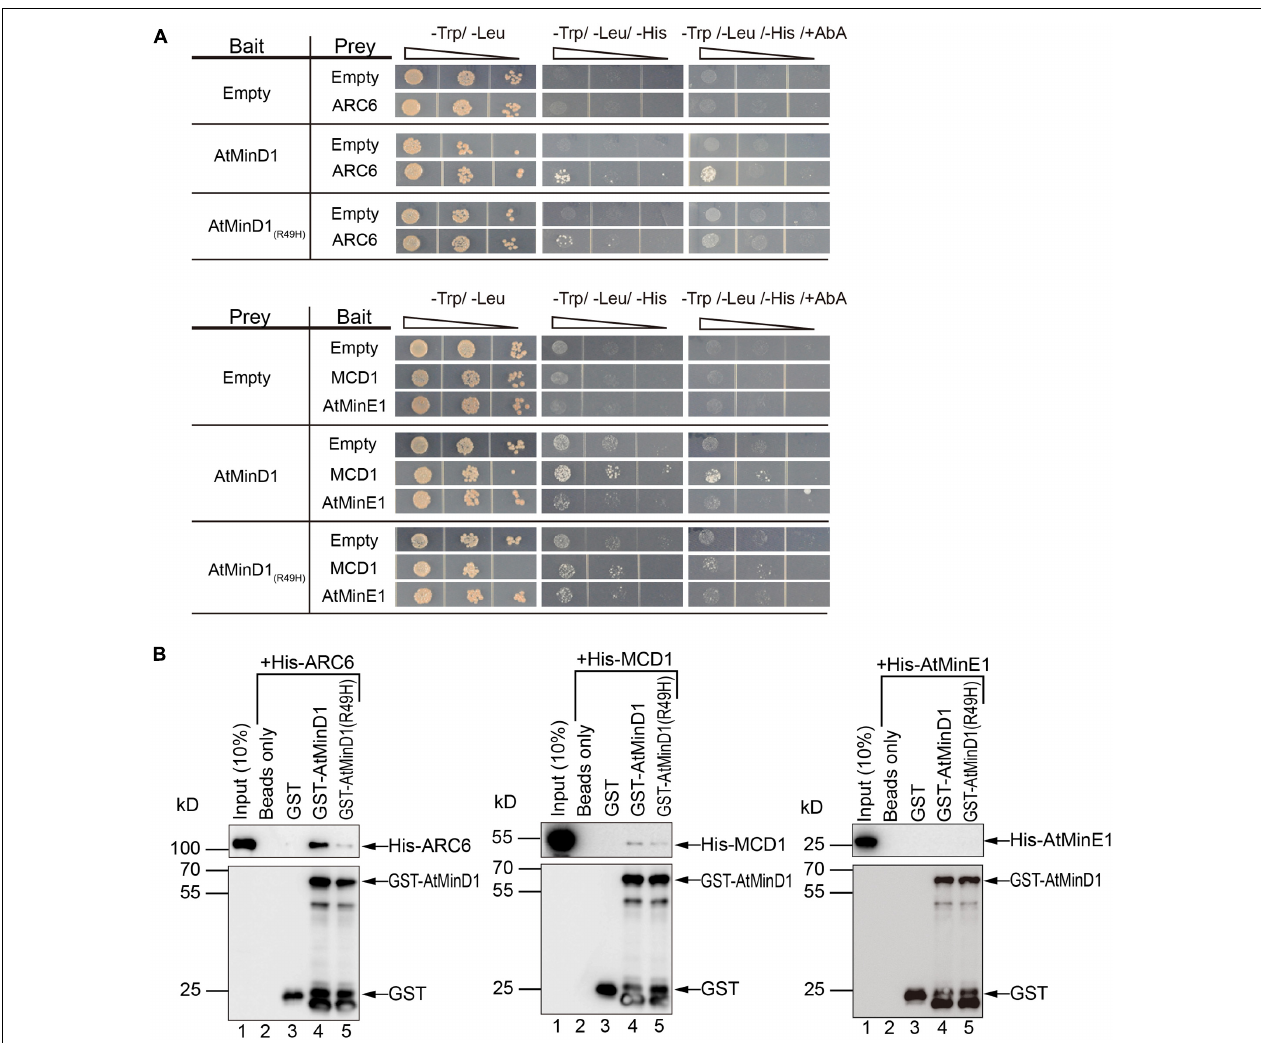
FIGURE 5 | Interaction between AtMinD1 or cdm75 and chloroplast division-related proteins (ARC6, MCD1, and AtMinE1). (A) Yeast two hybrid system investigating the interactions of AtMinD1 or cdm75 with ARC6, and MCD1, and AtMinE1. AD, constructs in the pGAD-T7 vector backbone; BD, constructs in the pGBK-T7 vector backbone; AbA, 40 ng/ml of Aureobasidin A; Yeast cells grown in different types of medium. Two biological replicates were performed. (B) Pull-down analysis of the interactions of AtMinD1 or cdm75 with ARC6, MCD1, and AtMinE1. Recombinant His-ARC6, His-MCD1, and His-AtMinE1 binds to GST-AtMinD1 or GST-AtMinD1(R49H). Glutathione Sepharose 4B beads were treated with a buffer only (lane 2) or coated with GST (lane 3), GST-AtMinD1 (lane 4), or GST-AtMinD1(R49H) (lane 5). The beads were then incubated with crude extracts of Escherichia coli cells expressing His-ARC6, His-MCD1, or His-AtMinE1. Proteins were eluted and analyzed by immunoblotting with anti-His and anti-GST